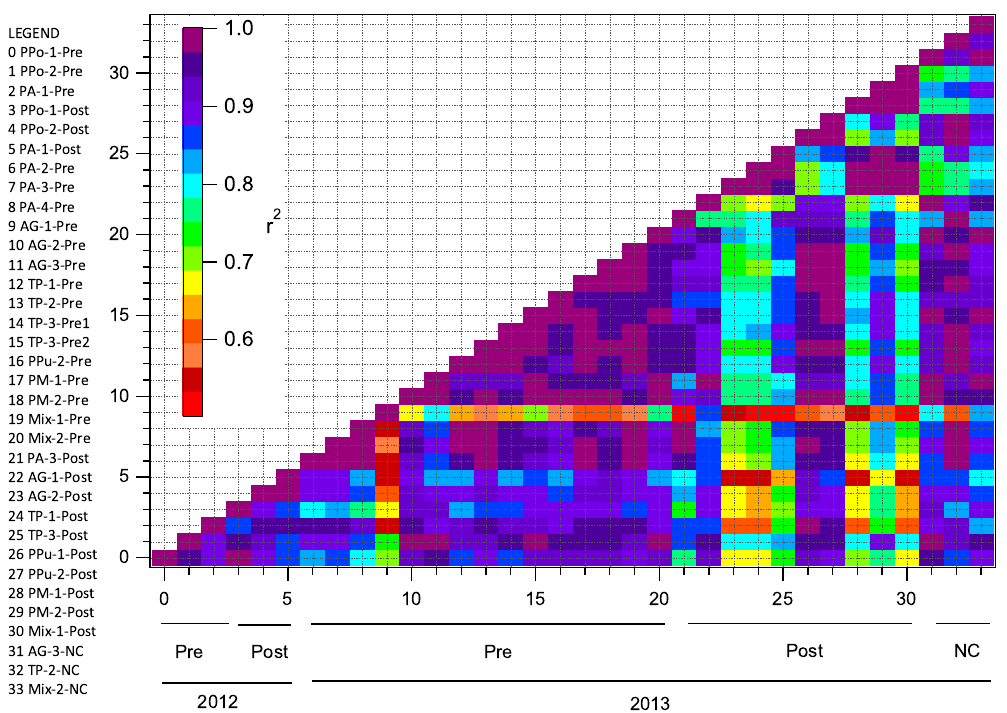
Figure 2. Summary of all comparisons between biogenic SOA spectra. Each number on the x and y axes refers to a single SOA growth experiment. The legend provides a key to match the axis number with its corresponding experiment ID. Details of each experiment are listed by experiment ID in Tables 1 and 2. The color scale denotes the strength of correlation between the two spectra. Due to air interferences, m/z 28 was removed from the spectra for all comparisons. The figure was organized by year followed by experiment type (pre-treatment, post-treatment, negative control) followed by tree type. NC is negative